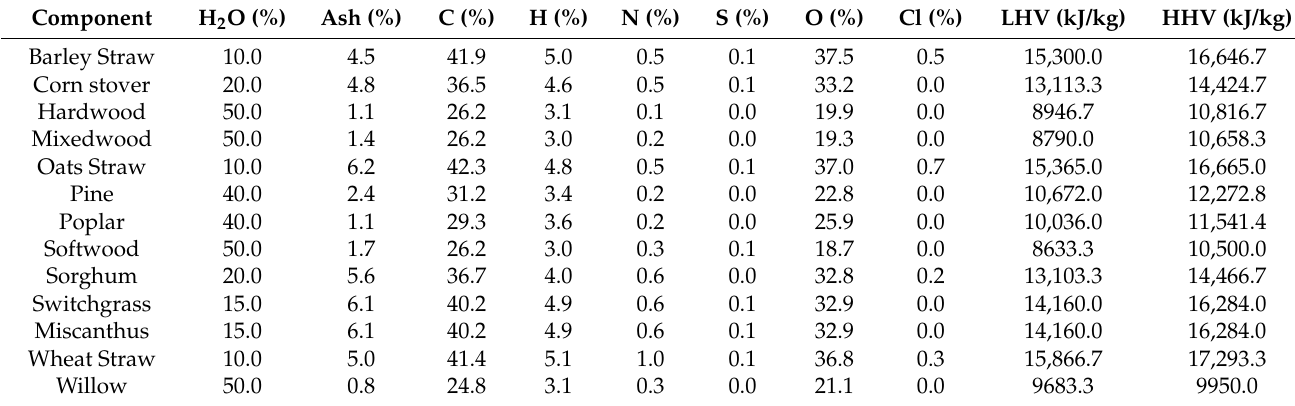
Table A2. Proximate analysis of non-pelletized biomass feedstocks used for PBC and IBGCC simulations. Component Barley